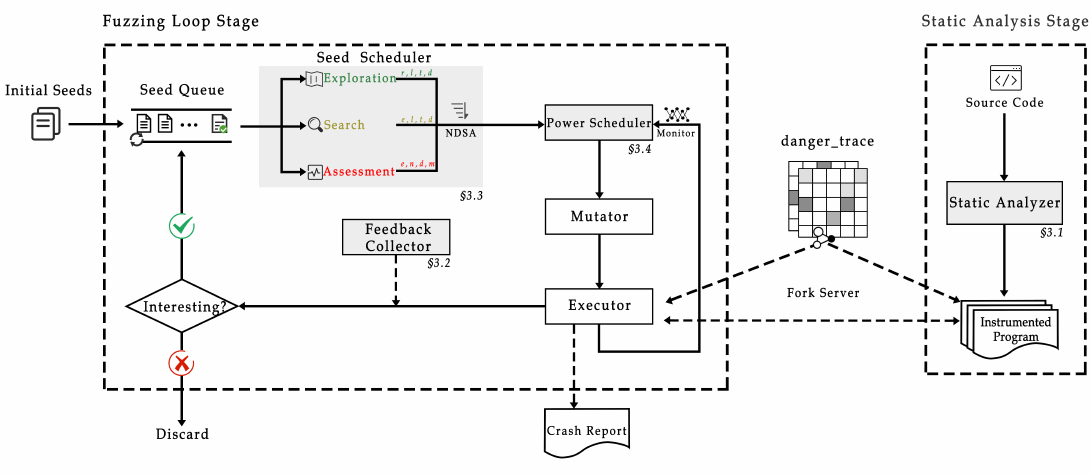
Figure 2. A high-level overview of MooFuzz.